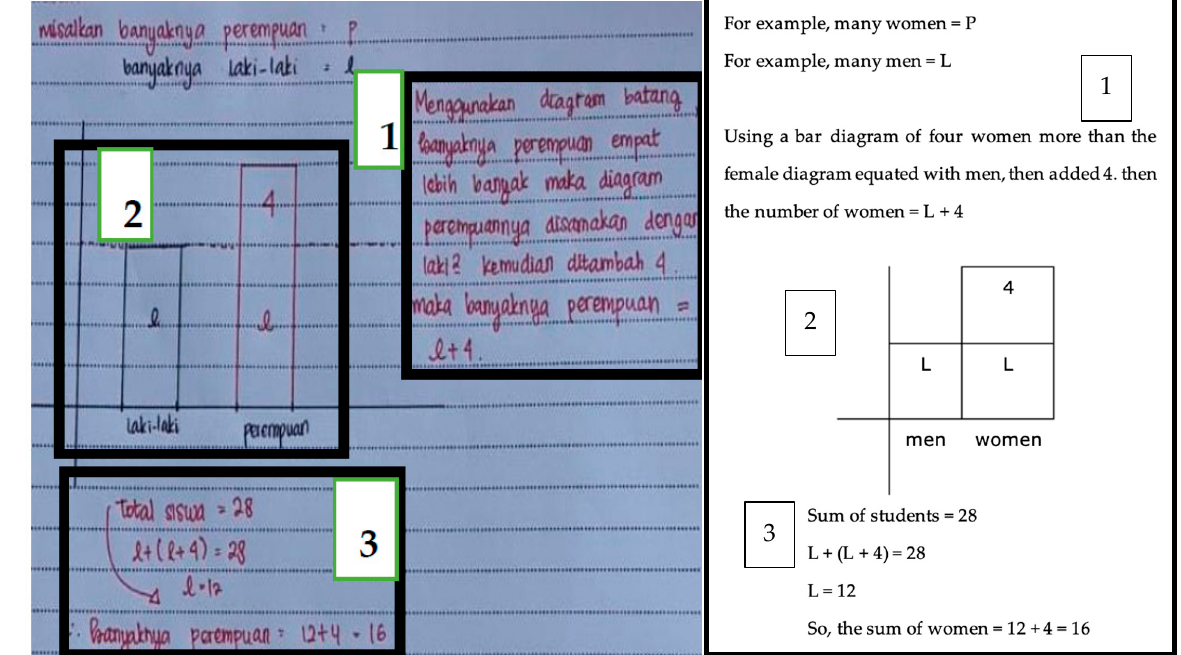
Figure 4. The representation produced by S2.